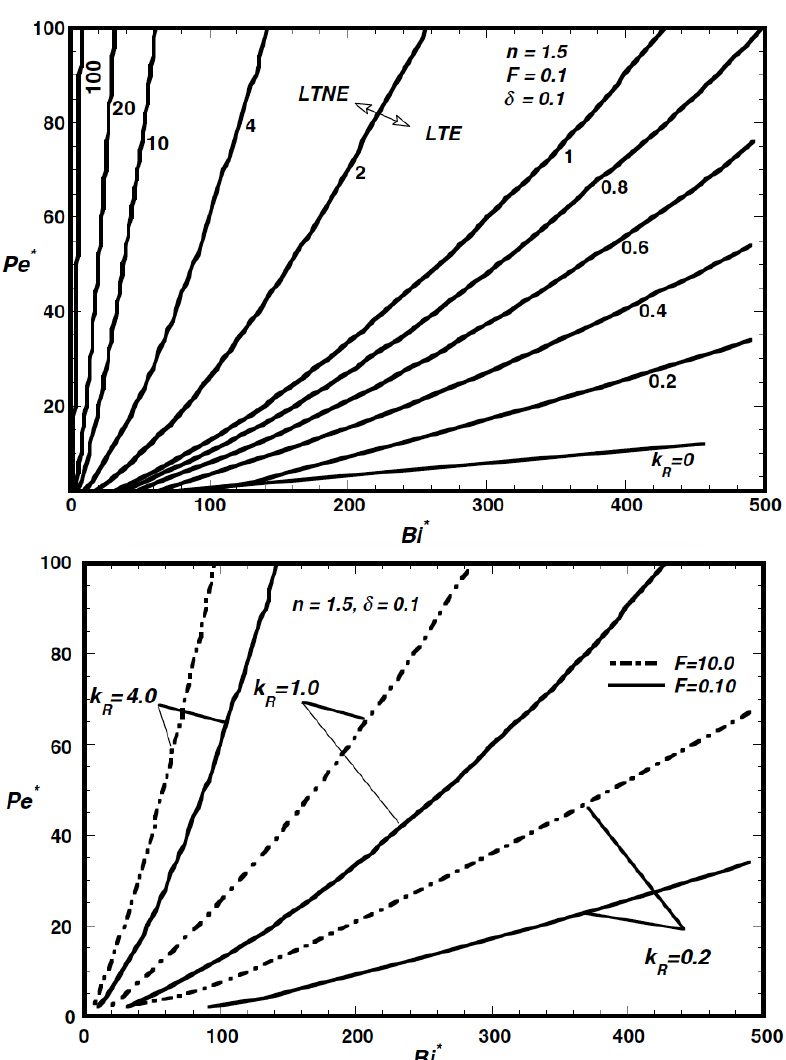
Figure 22. Influence of modified Péclet number ( Pe ∗ ), volumetric Biot number ( Bi ∗ ), fluid/solid thermal capacity ratio ( k R ), and Forchheimer parameter ( F ) on the LTE validity maps, presented by Khashan and Al-Nimr